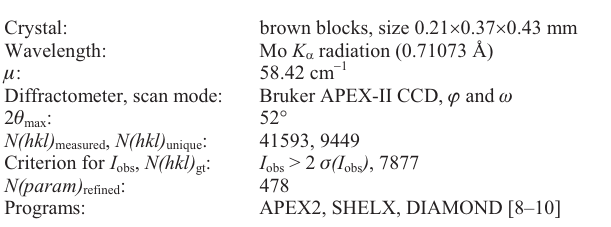
Table 1. Data collection and